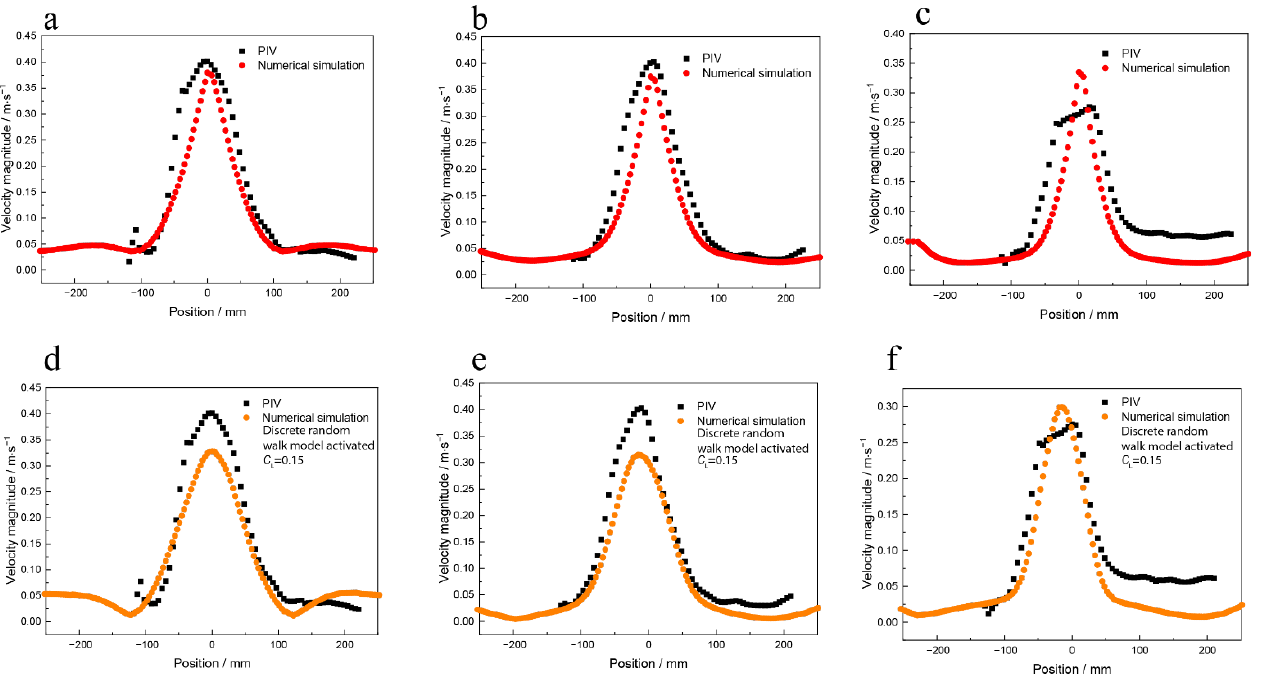
Figure 5. The quantitative velocity magnitude data of numerical simulation of water model and PIV measurements results, when the random walk model was deactivated ( a ) near the water surface, ( b ) under the water surface by 100 mm, and ( c ) under the water surface by 200 mm; when the random walk model was activated and the C L was 0.15 ( d ) near the water surface, ( e ) under the water surface by 100 mm, and ( f ) under the water surface by 200 mm.